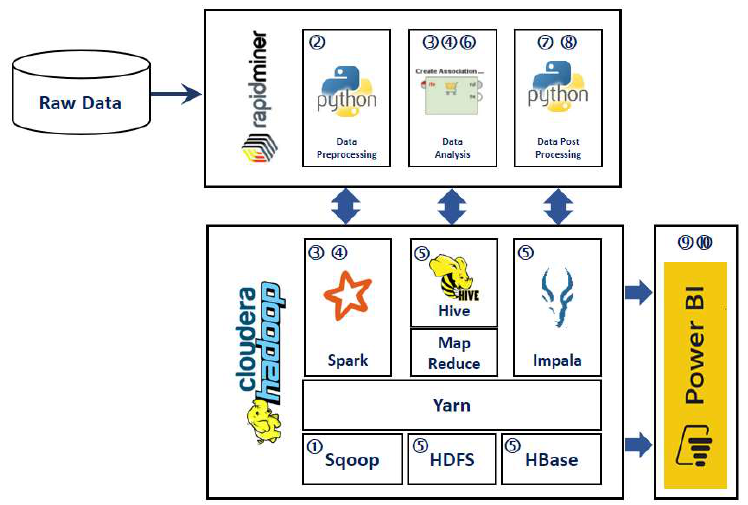
Figure 6. SCDAP prototype physical realization using CDH, RapidMiner, and Power BI.